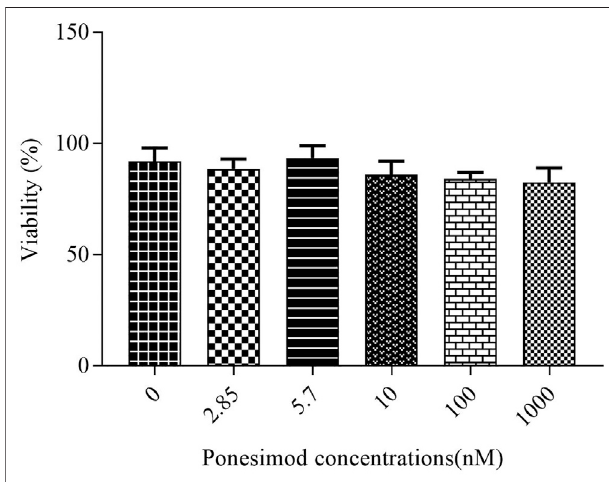
FIGURE 4 | After treatment of the oligodendrocyte cell line with the ponesimod, cell survival was equal with control in all concentrations.